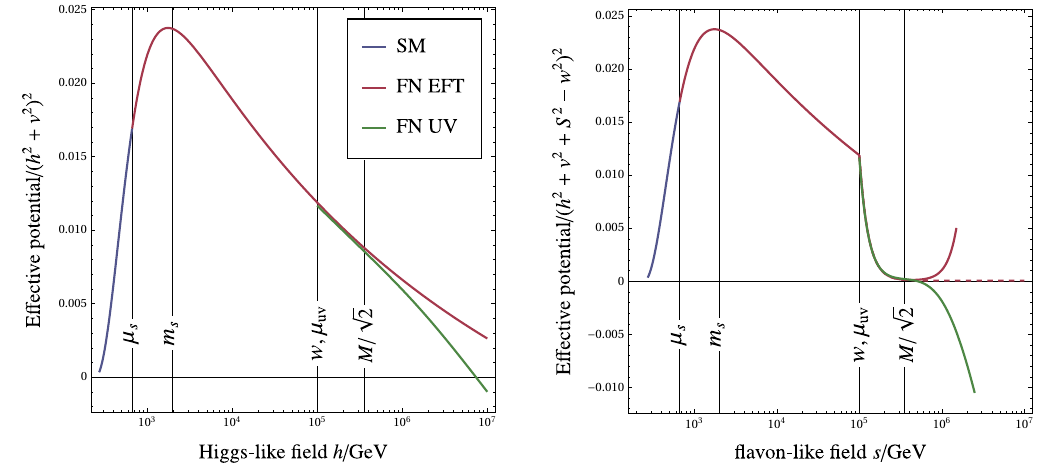
Figure 4 . E(cid:11)ective potential along the axes from (cid:12)gure 2. The left part of the plots are identical and show the potential for (cid:12)xed s = w and variable h . Beyond this point, we show the potential along the h -direction (left) and s -direction with h = w (right). The dashed line corresponds to the tree level EFT. In this (cid:12)gure we have chosen the NP scales to be m (cid:27) = 2 TeV and M = 5 (cid:2) 10 5 TeV. The measured Cabibbo angle then requires w = (cid:15)M ’ 10 5 TeV. In both plots the scalar mixing angle is set to (cid:18) =